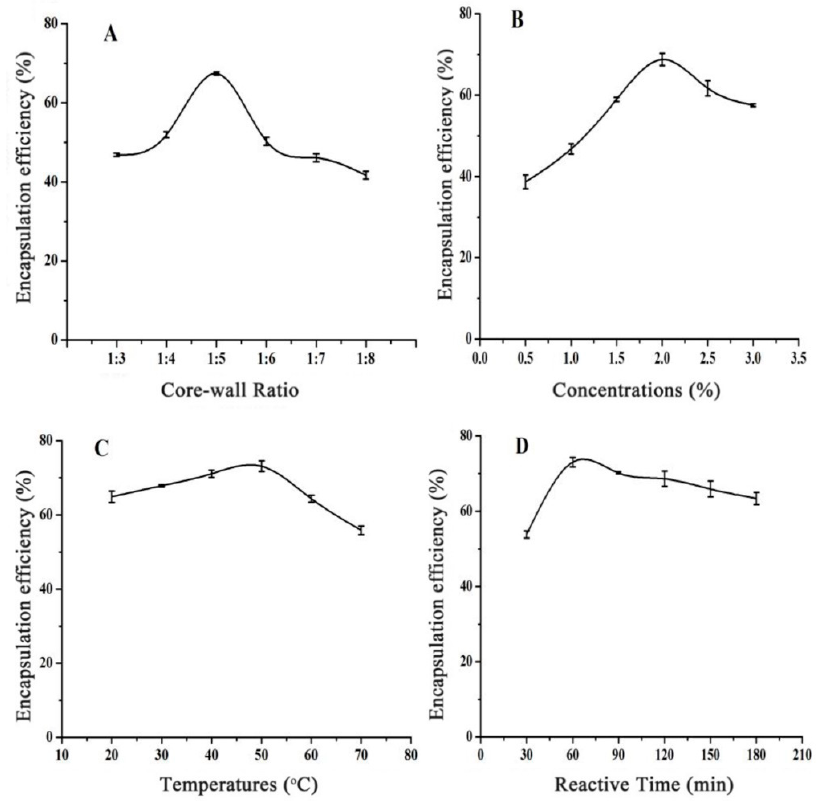
Figure 1. Effects of different conditions to prepare ginger essential oil (GEO)/ β -CD composite: ( A ) Core-wall ratio; ( B ) Wall material concentration; ( C ) Temperature; ( D ) Reactive time.